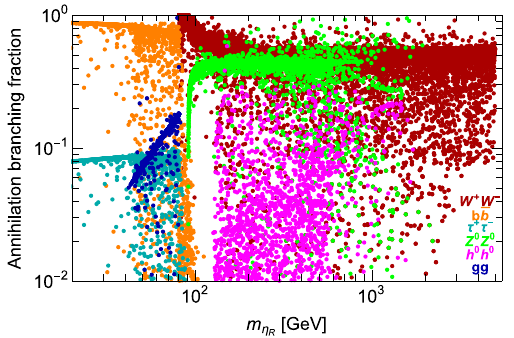
Fig. 5 Spin-independent η R -nucleon elastic scattering cross section Fig. 4 Main branching fractions of the annihilation cross section of versus the η R mass. Colour code as in Fig 3. The dark green line denotes η η R into SM final states versus the mass of R . Orange points refer to the most recent upper bound from XENON1T [56]. The dashed orange annihilation into b ¯ b , dark cyan to τ + τ − , blue to gluons, dark red to line depicts the lower limit corresponding to the “neutrino floor” from W + W − , green to Z 0 Z 0 and magenta to h 0 h 0 coherent elastic neutrino-nucleus scattering (CE ν NS) [62], while the green dot-dashed one stands for the projected sensitivity for LZ